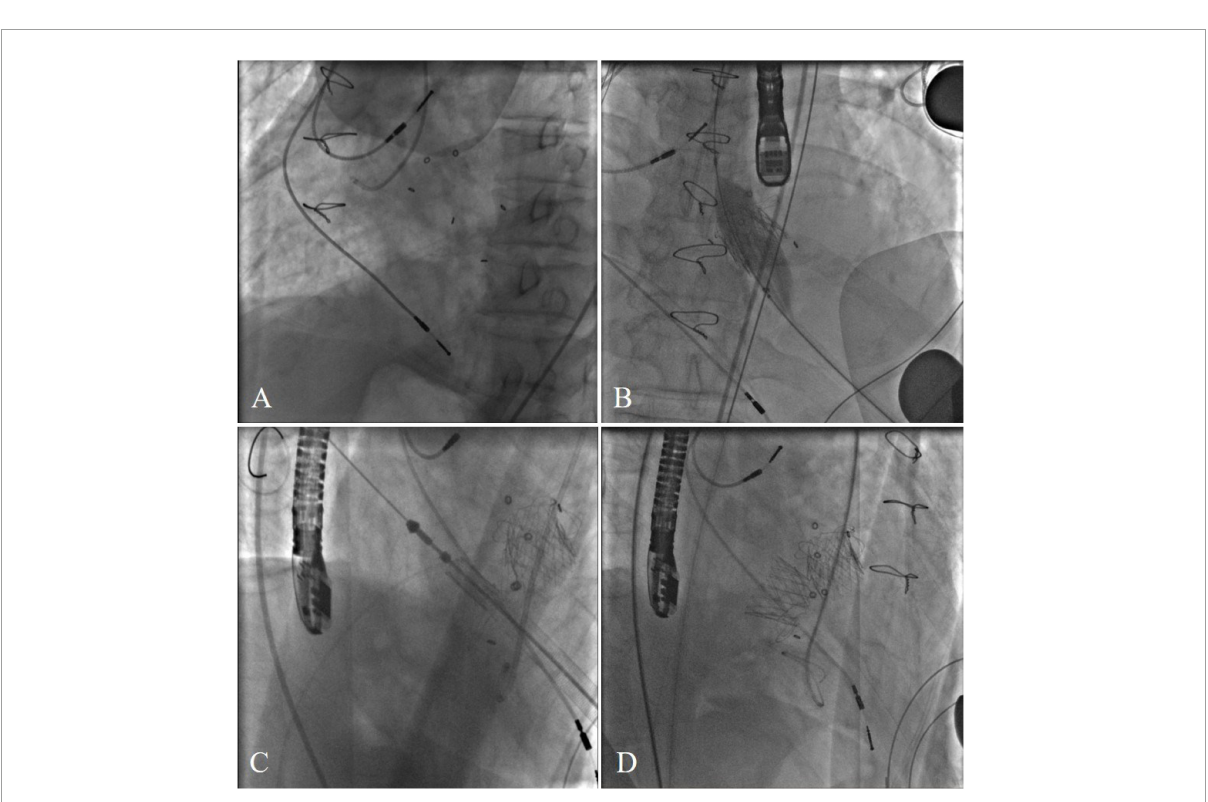
FIGURE2 (A) The annulus of the Medtronic Mosaic aortic and mitral bioprosthesis was not visualized on fluoroscopy. (B) A total of 20 mm Atlas gold post-dilatation was used for post-dilatation in the aortic position. (C) Transcatheter bioprosthetic mitral valve implantation. (D) Final cardiac fluoroscopy showing both valves deployed and seated